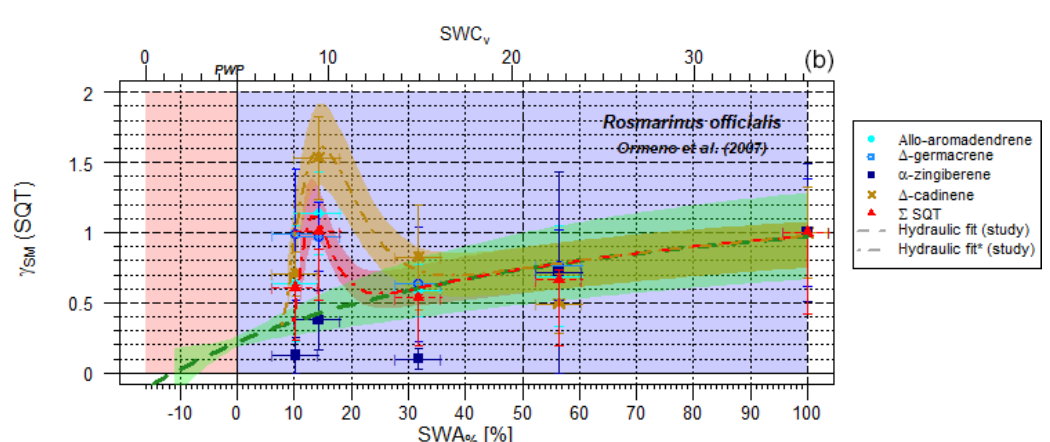
Figure 4. Exemplary scaling parameter γ SM for the effect of soil moisture with a maximum at PWP on individual and total terpene emissions as a function of SWA % (lower x axis) and, for comparison, the SWC v at Freiamt soil conditions (upper x axis) ( Cistus albidus ) (Ormeño et al., 2007). (a) SM effect on monoterpene emission fluxes of individual structured monoterpenes, as well as of the total sum of monoterpenes. (b) The same data as (a) but for individual structures and the total sum of sesquiterpene emissions ( Rosmarinus officialis ) (Ormeño et al.,